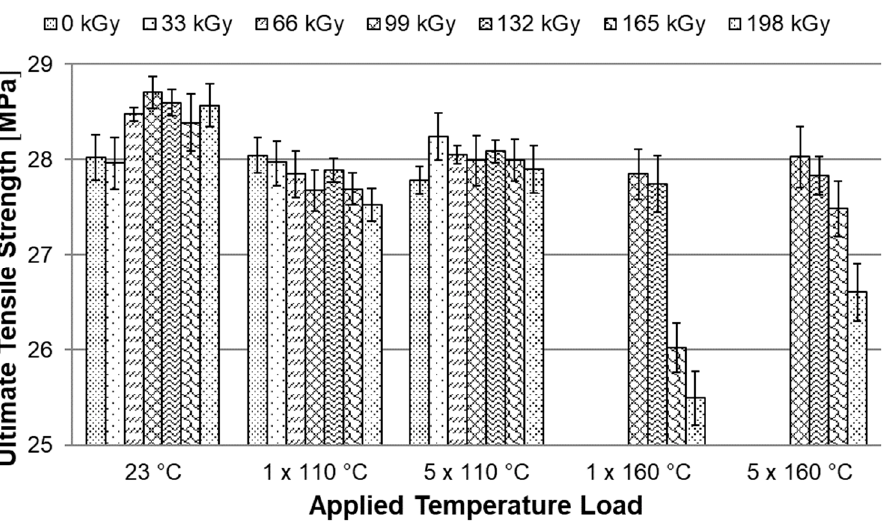
Figure 11. Dependence of ultimate tensile strength on applied temperature load.